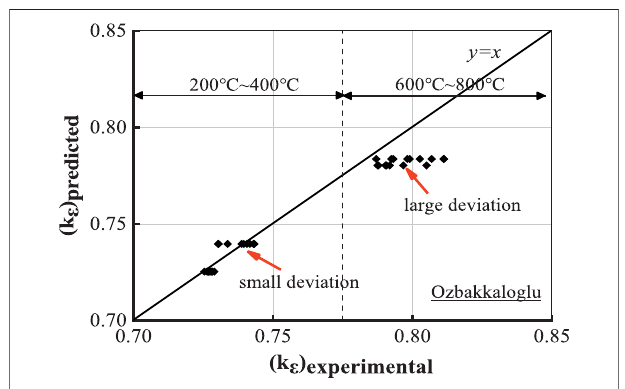
FIGURE 9 | Performance of typical model in predicting BFRP ef fi ciency factor.